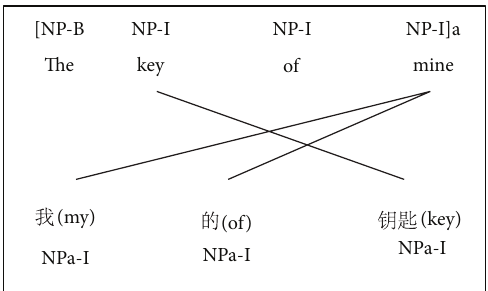
Figure 1: Direct label projection from English to Chinese with position information.